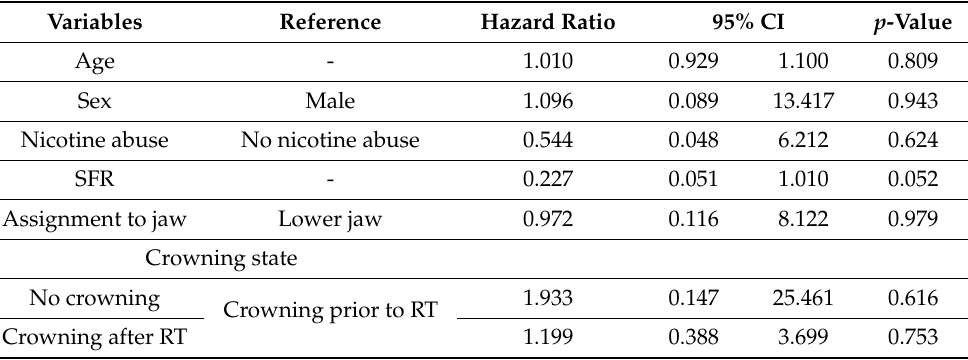
Table 4. Hazard ratios of demographic and clinical characteristics of non-irradiated patients for survival of